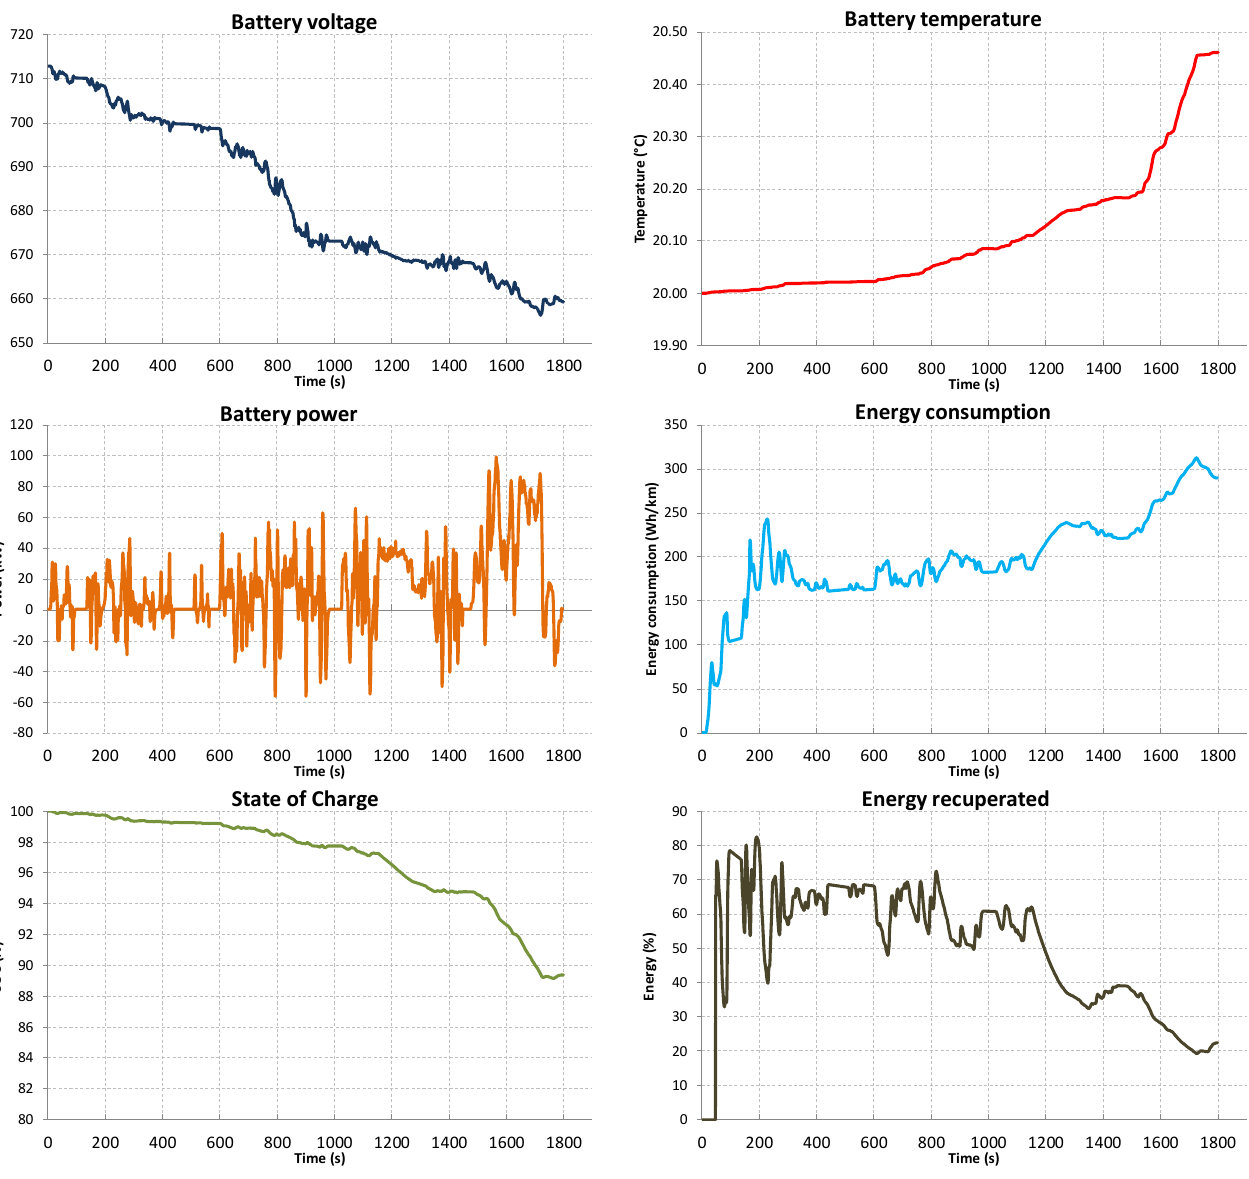
Figure 16. WLTC 3b-results of simulation tests for the 4 × 4 drive system.